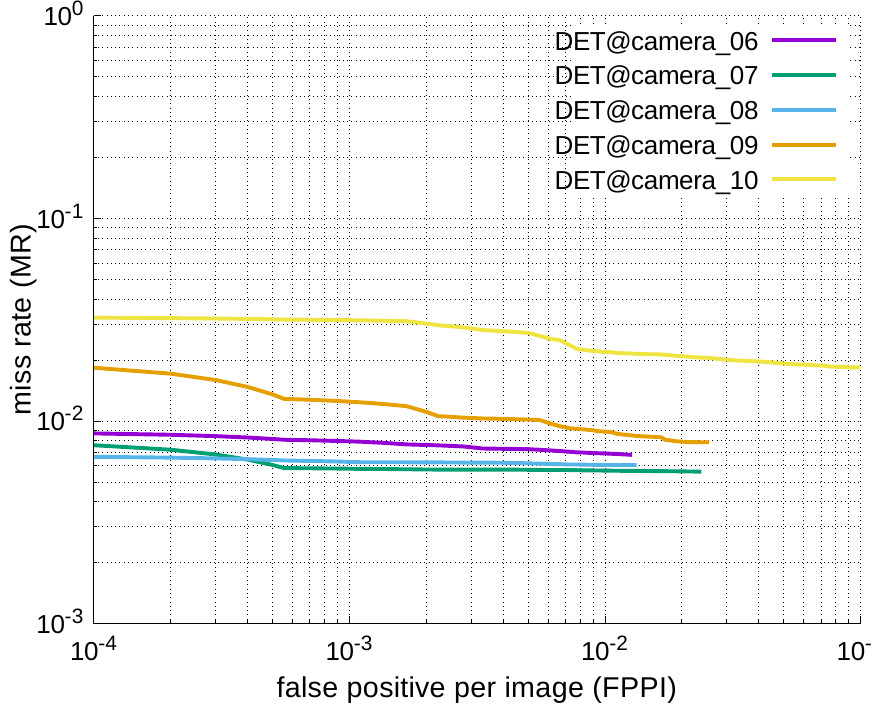
Figure 27. DET curves @ Cameras_06–10, informed-filters, some viewpoints.